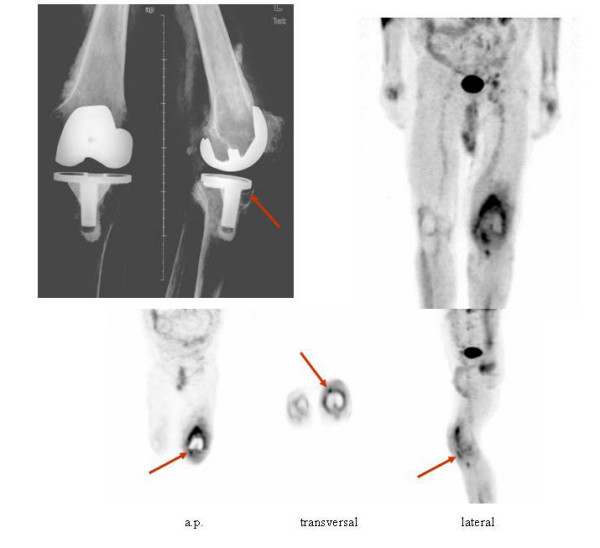
Intraoperatively confirmed loosening of the proximal and distal components. An infection with coagulase negative staphylococcus was also identified. PET was initially interpreted as synovialitis without signs of mechanical loosening. The inflamed synovium as well as the periprosthetic osteolytic areas (arrow) filled with bacteria-infected granulation tissue showed 18F-FDG uptake.